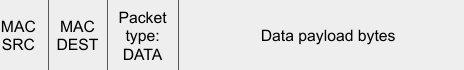
Figure 9. Data packet